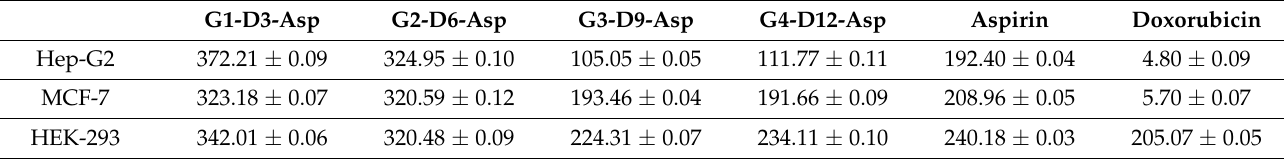
Table 2. Cytotoxicity of G1-G4 aspirin-based dendrimer and aspirin.